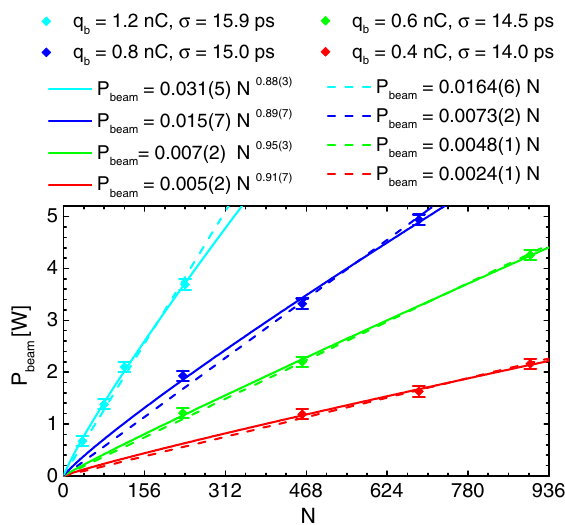
FIG. 3. Beam heat load as a function of the number of bunches for four different bunch charges. For each set a linear fit (dashed line) and a power law (solid line) through the origin is